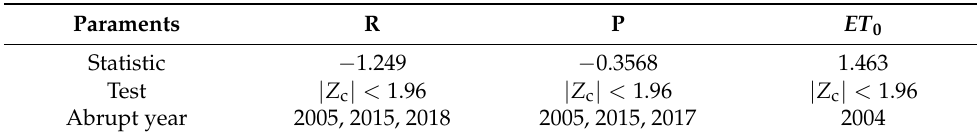
Table 2. Trend and mutation test results of runoff depth and precipitation and potential evaporation in Wujiang.